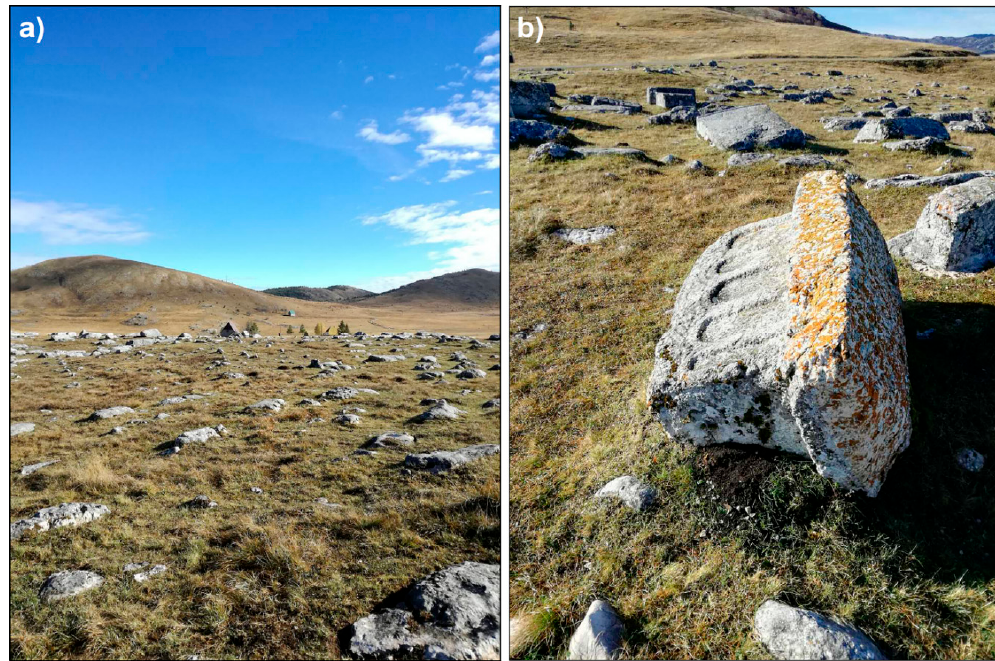
Figure 20. Ste´cci of Žugi´ca: view of the necropolis ( a ) and a particular of a decorated tombstone ( b ).